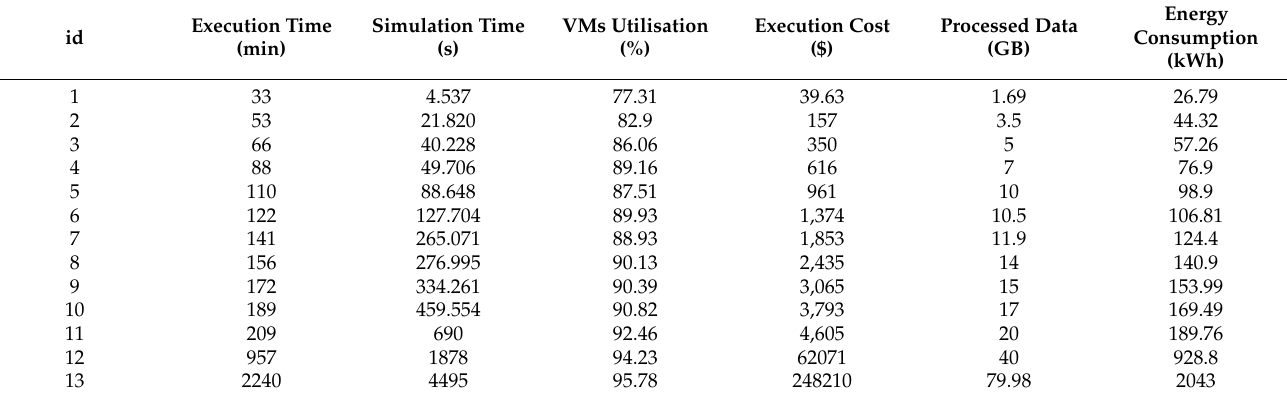
Figure 3. A sample IoT workflow with sensors, services, and actuators. Table 7. The experimental results of DISSECT-CF-Fog with different numbers of IoT